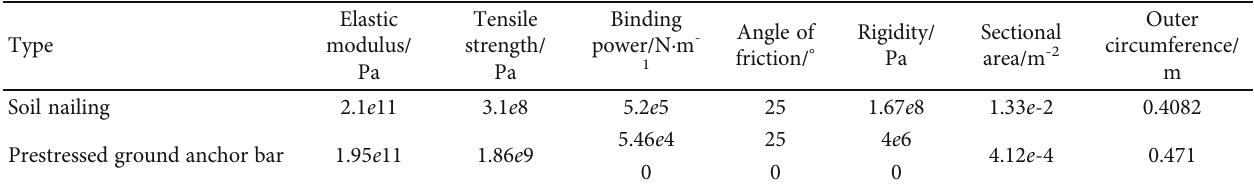
Table 5: Parameters of anchor and soil nailing elements.